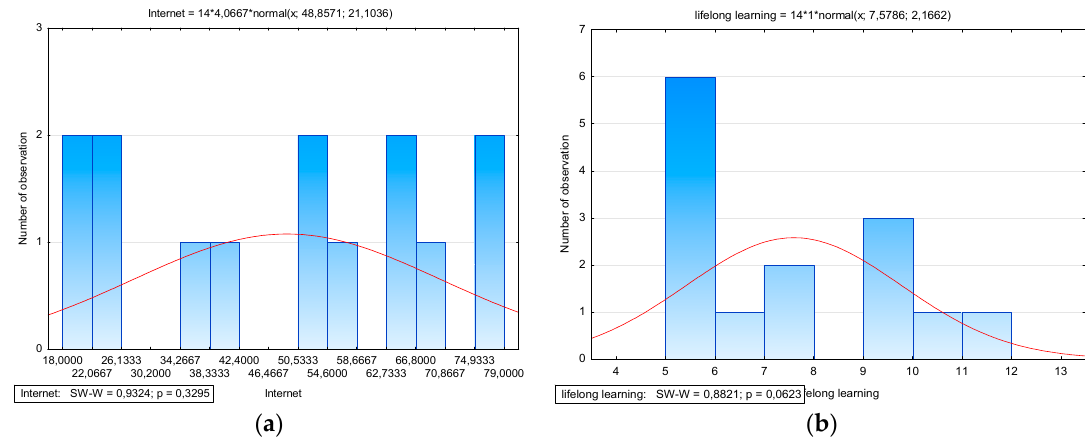
Figure 5. ( a ) Data distribution among Internet users; ( b ) data distribution in terms of lifelong learning.